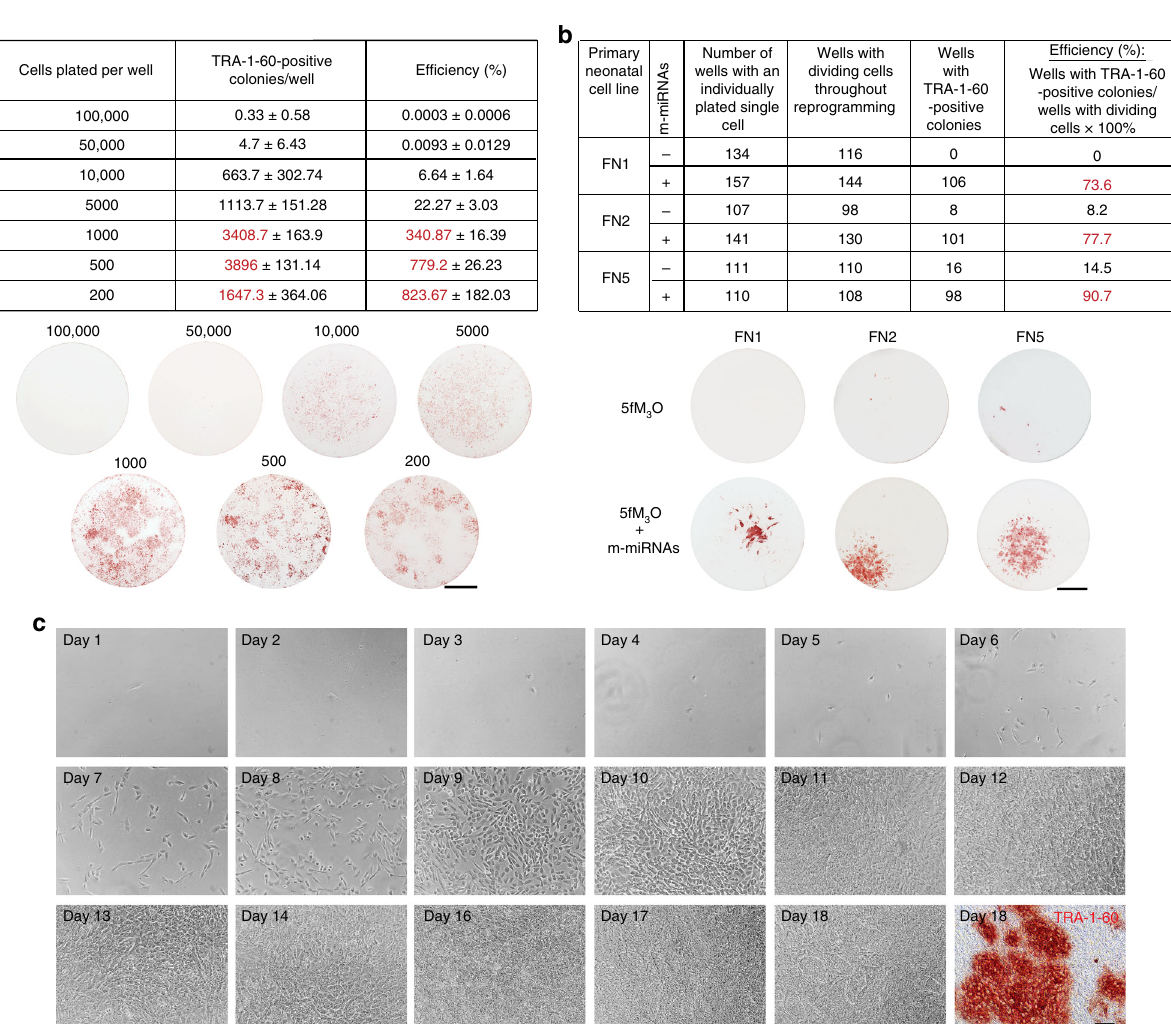
Fig. 4 Low initial cell plating densities improve the ef fi ciency of the RNA-based reprogramming approach. a Summary table and representative TRA-1-60- stained reprogramming wells showing the yield of TRA-1-60-positive colonies at day 18 of the optimized RNA-based reprogramming regimen (see Fig. 1b) initiated with human primary neonatal fi broblasts (FN2) at the indicated cell plating numbers per well of a 6-well format dish. The ef fi ciency was calculated by dividing the number of resulting TRA-1-60-positive colonies by the number of input cells and multiplying by 100%. Mean± s.d. ( n = 3). Scale bar, 10 mm. Similar results were obtained using an independent primary neonatal fi broblast line, FN1 (Supplementary Fig. 5). b Summary table showing the reprogramming of individually plated single cells with the 5fM 3 O mod-mRNA reprogramming cocktail delivered alone or in combination with m-miRNAs every 48 h using Opti-MEM adjusted to a pH of 8.2 as the transfection buffer (see Fig. 1b). The number of individually plated single cells from three independent primary neonatal fi broblast lines (FN1, FN2, and FN5), the survival of these cells throughout reprogramming, and the resulting number of wells with at least one TRA-1-60-positive colony at day 18 of reprogramming are shown. The ef fi ciency was calculated by dividing the number of wells with TRA- 1-60-positive colonies by the number of wells with surviving input cells and multiplying by 100%. Representative TRA-1-60-stained reprogramming wells (48-well dish format) correspond to conditions from the summary table. Note the formation of multiple sister TRA-1-60-positive colonies when both mod- mRNA and m-miRNA transfections were employed. Scale bar, 3 mm. c Representative day-by-day images of single-cell reprogramming (FN2) performed with the optimized RNA-based reprogramming approach. Staining for TRA-1-60 performed on day 18 of reprogramming is also shown. Scale bar, 100 µ